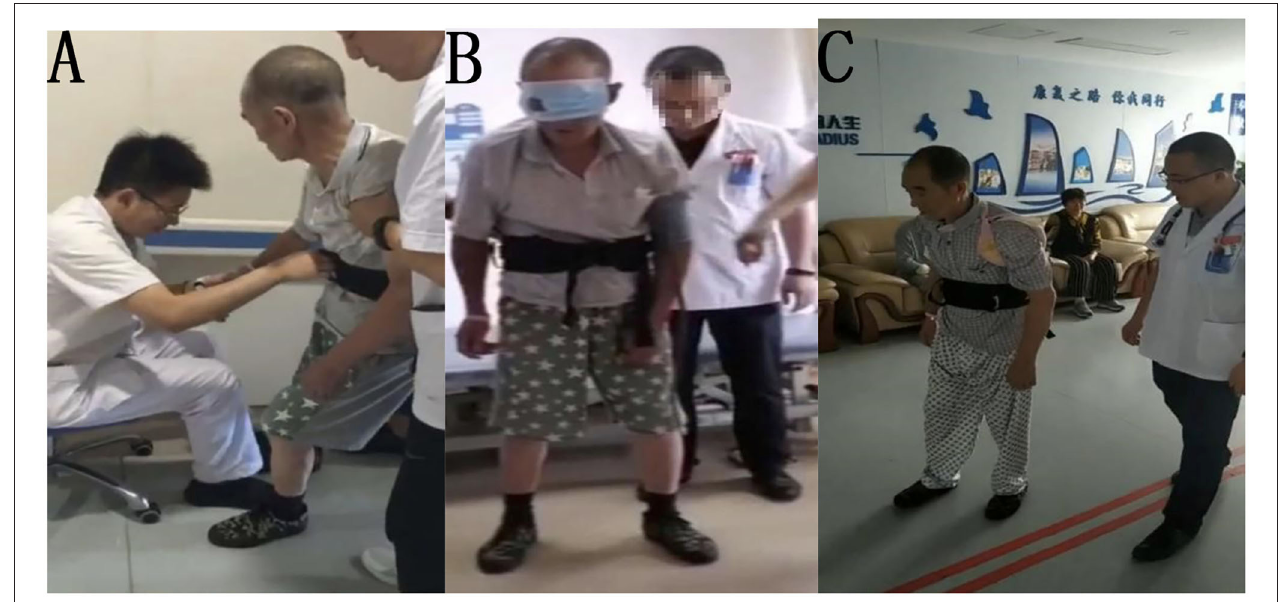
FIGURE 2 | (A) Before treatment, (B) during treatment, (C) after treatment.